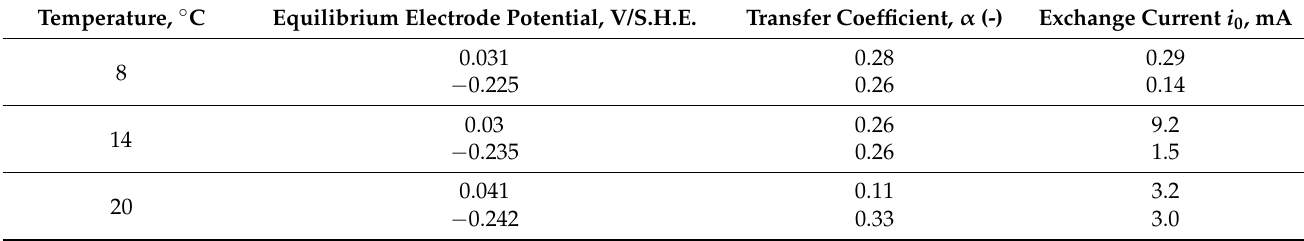
Table 2. Kinetic data obtained for the anode compartment, packed with granulated activated carbon at different tempera- tures. Sulfide concentration 63 mg dm − 3 .